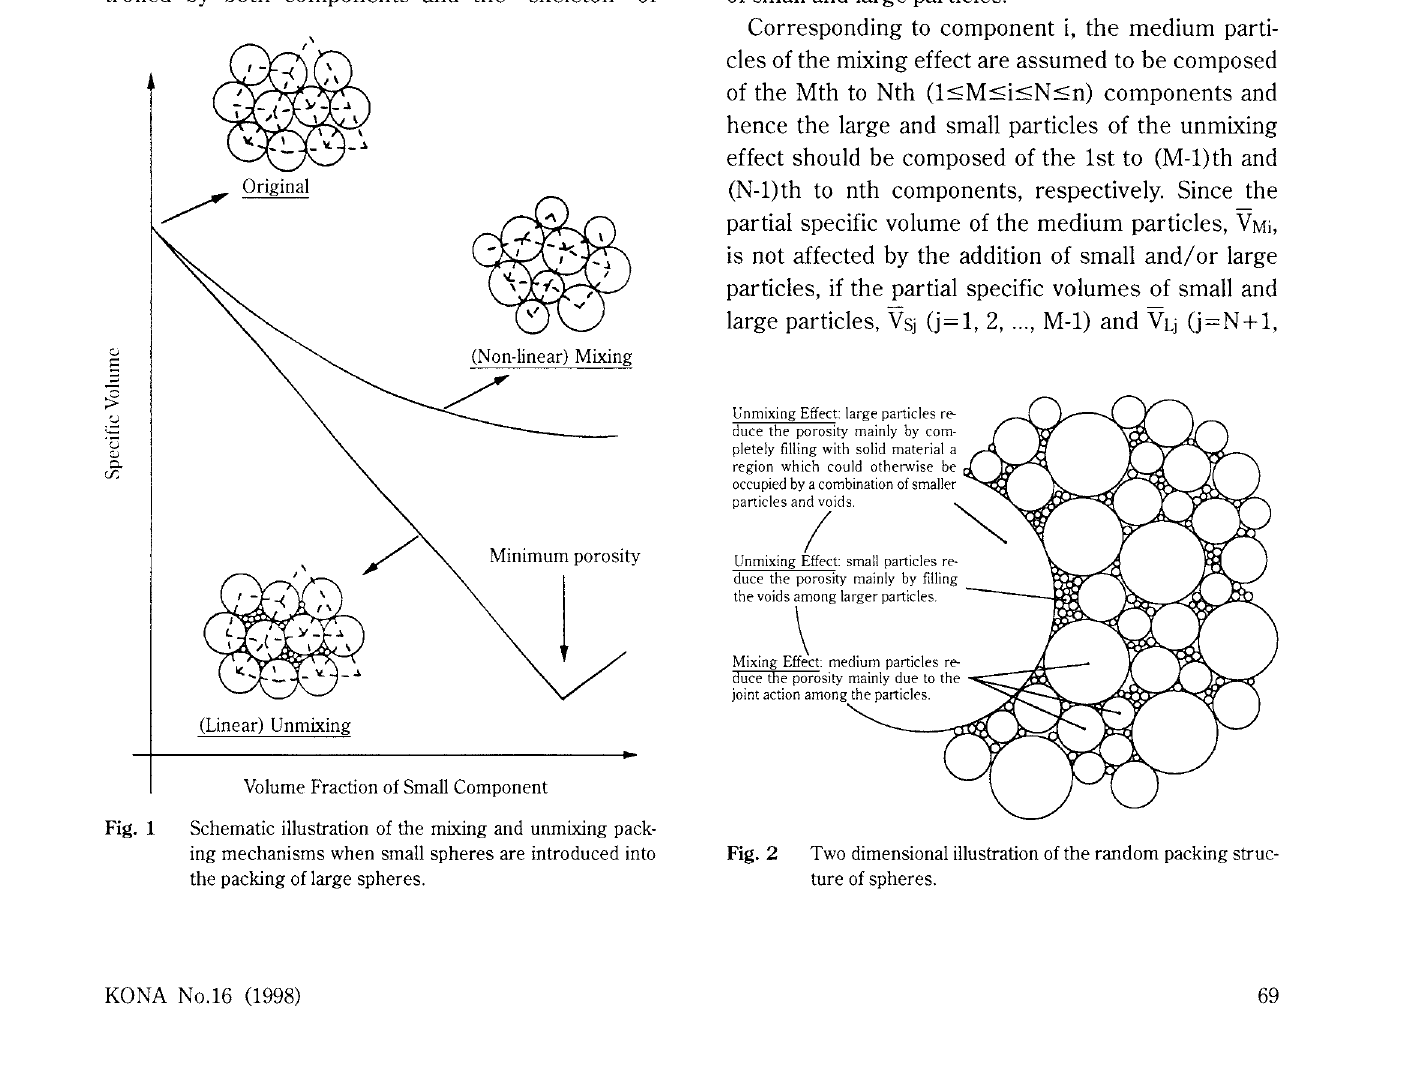
Fig. 2 Two dimensional illustration of the random packing struc ture of